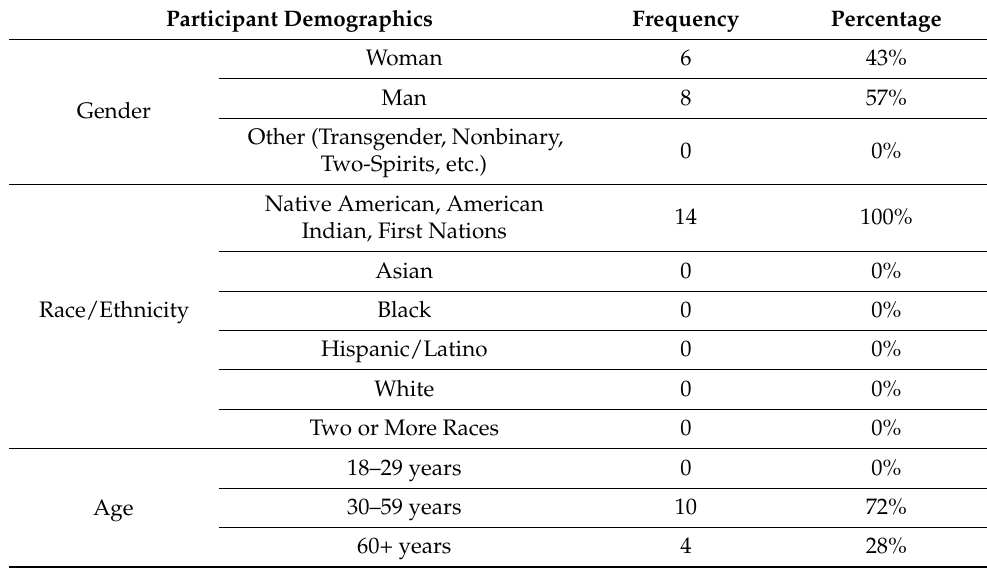
Table 1. Demographic characteristics of the interview participants (n =